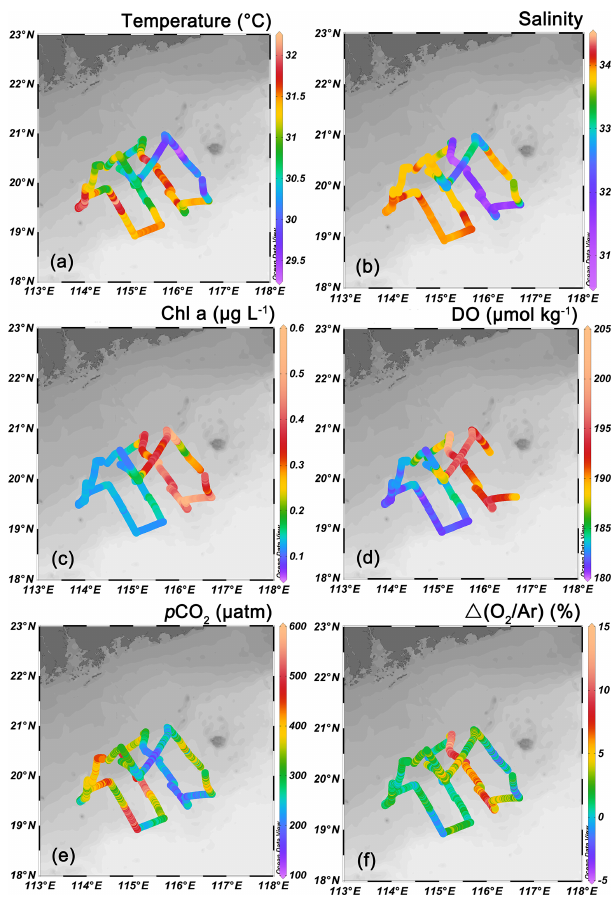
Figure 3. Surface distributions of (a) temperature, (b) salinity, (c) chlorophyll a (Chl a ), (d) dissolved oxygen (DO), (e) p CO 2 , and (f) (cid:49) (O 2 / Ar) in June 2015.